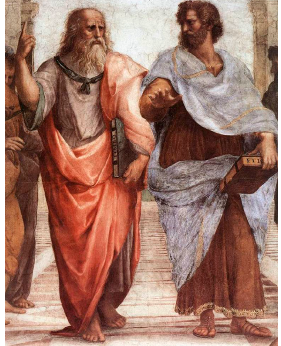
Figure 1. Plato (left) and Aristotle in a Raphael’s fresco (1509).